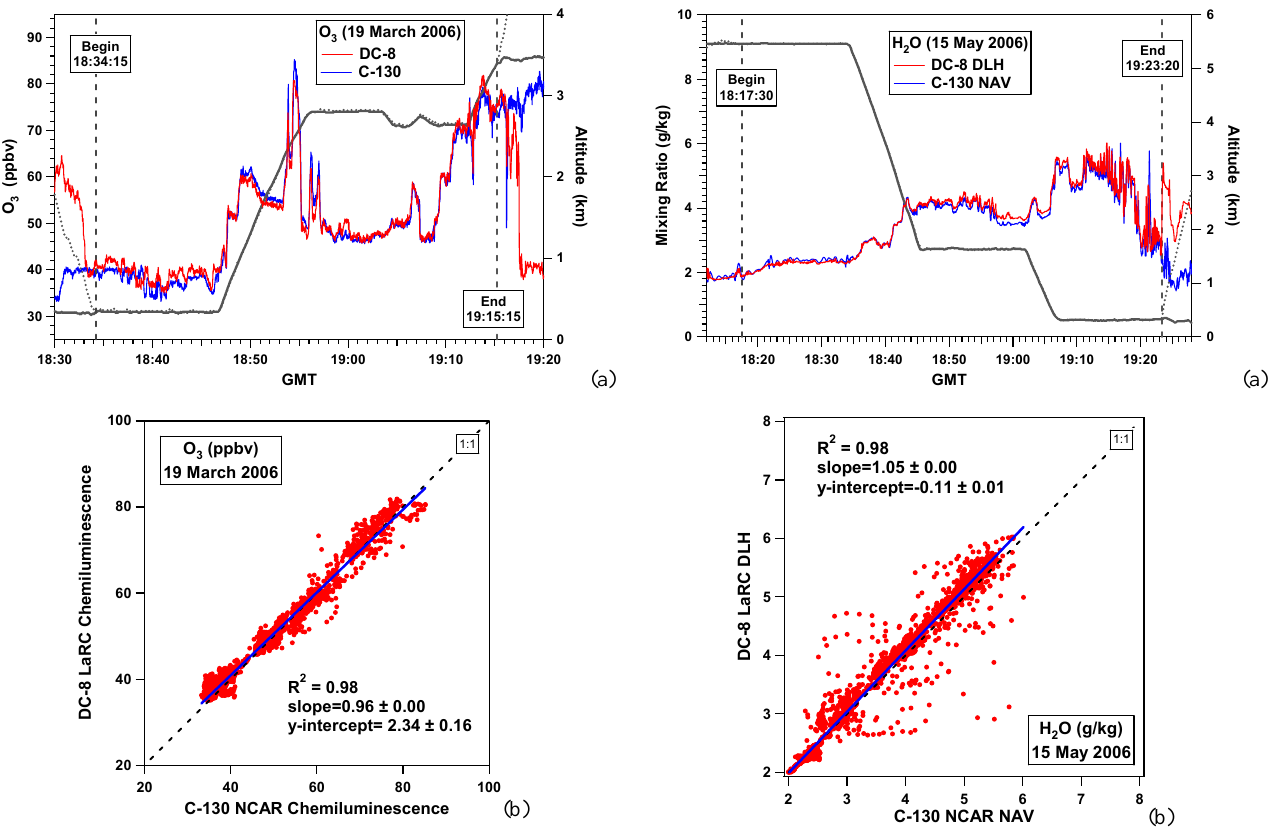
water, there is a slight time lag in one of the water measure- ments. This is evident in Fig. 3b where data points depart the tighter cluster in curved lines. In general the spread in the data appears larger for water than ozone, however, this may be due in part to the smaller range in the x and y scales for water. The high R 2 value for both ozone and water never- theless indicate that the two aircraft are most likely sampling the same